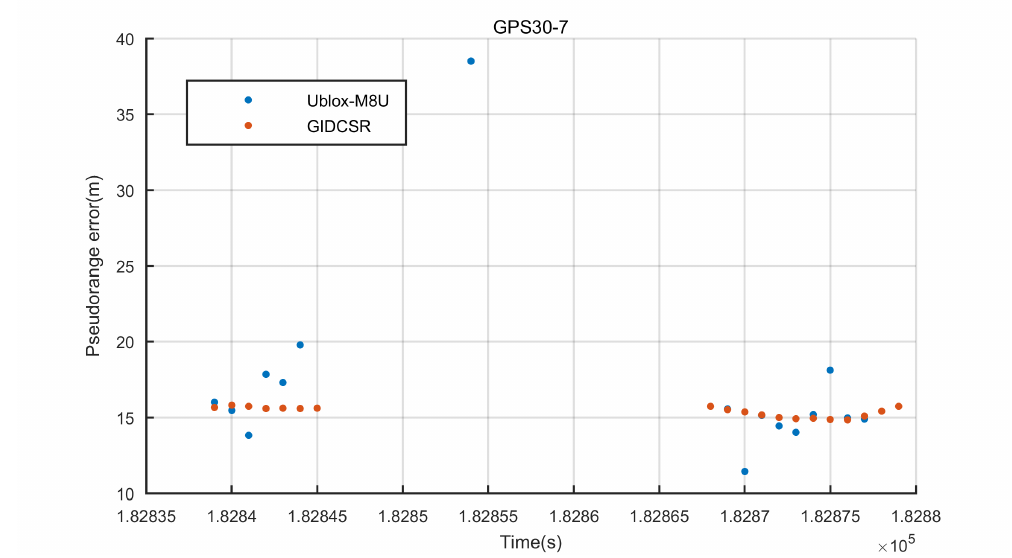
Figure 19. GPS 30 tracking